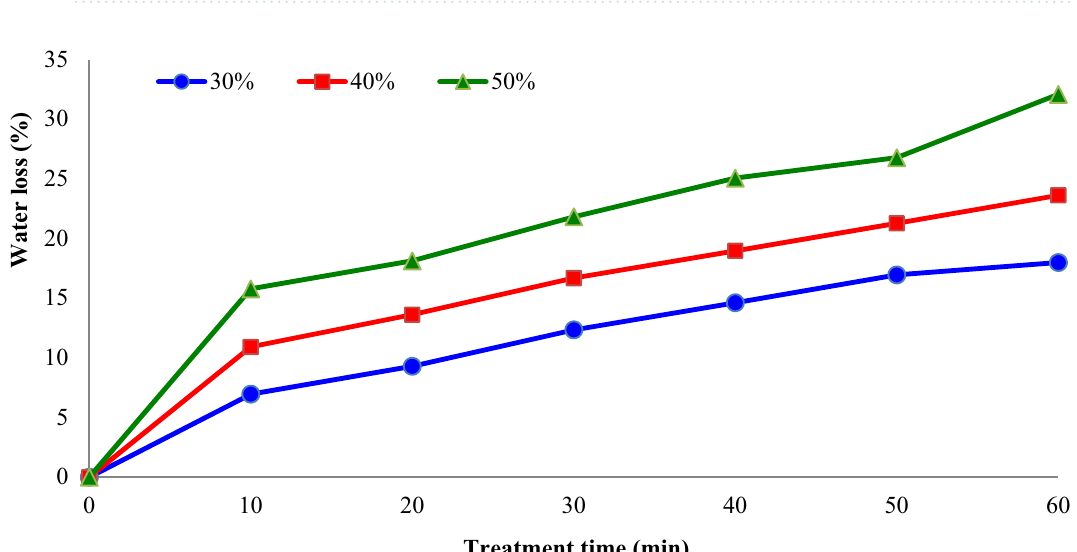
Figure 5. Impacts of sonication power and treatment time on the water loss (%) of apple slices during osmotic dehydration (concentration = 40° Brix).